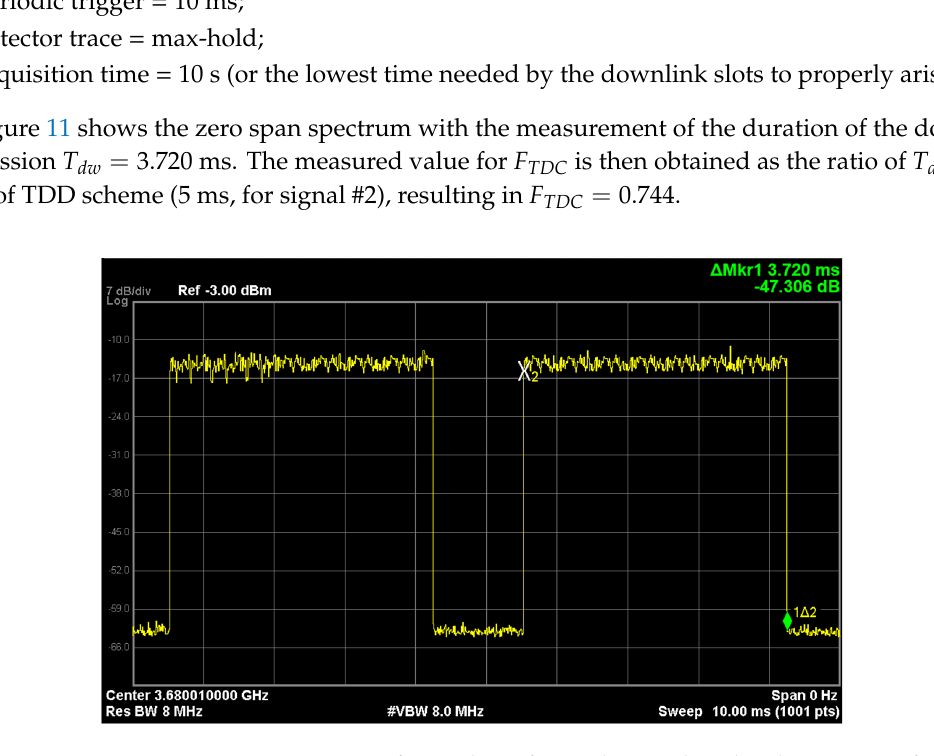
Figure 11. Zero span measurement of signal #2 for a duty-cycle related corrective factor (cid:4666)(cid:1832) (cid:3021)(cid:3005)(cid:3004) )